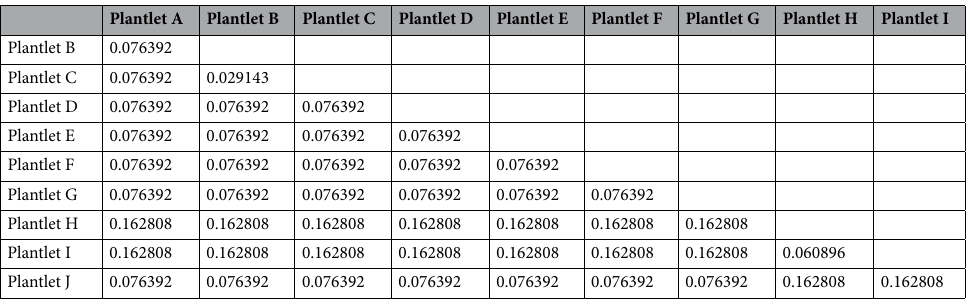
Table 2. The Jaccard’s dissimilarity distances generated from 10 randomly selected clonal plantlets